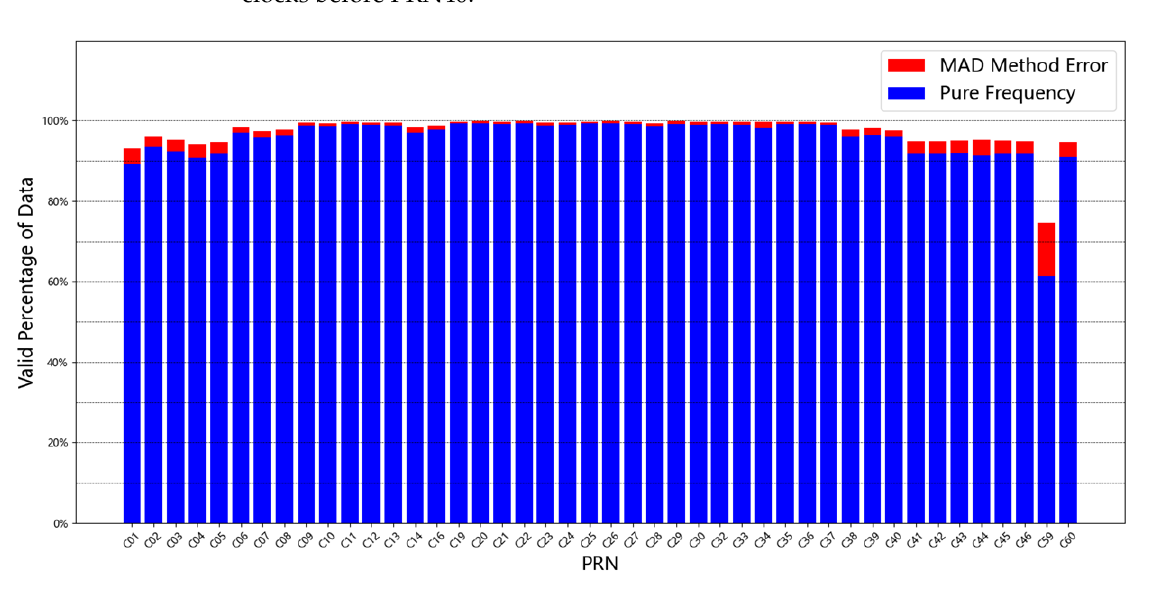
Figure 3. The Efficiency of the Clock Data after MAD Processing.